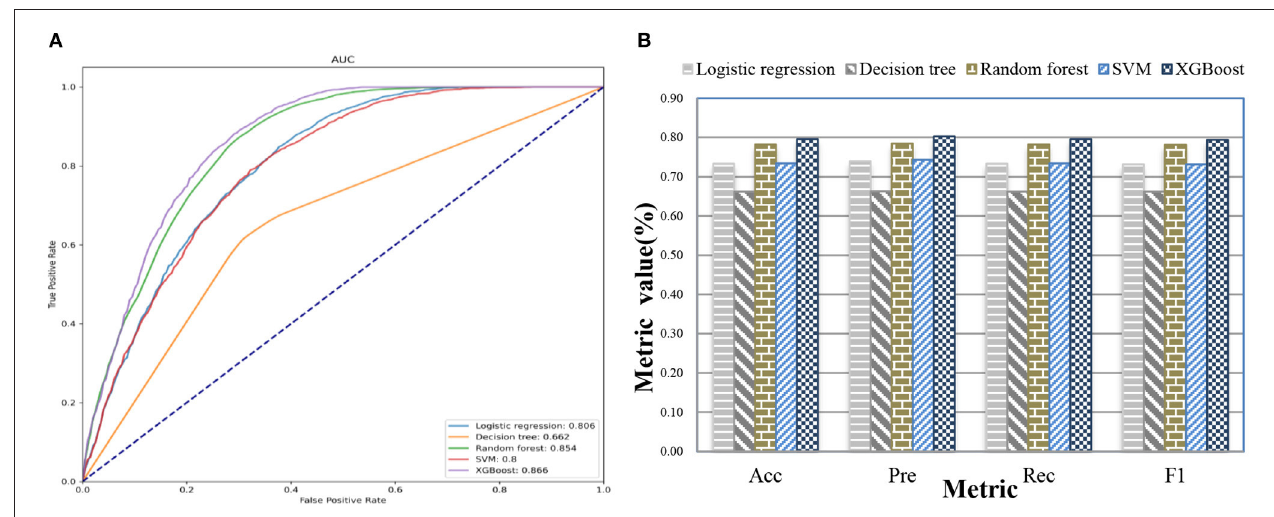
FIGURE 11 | Classification performance of the proposed UDIPM. (A) AUC. (B) Acc, Pre, Rec, and F1.